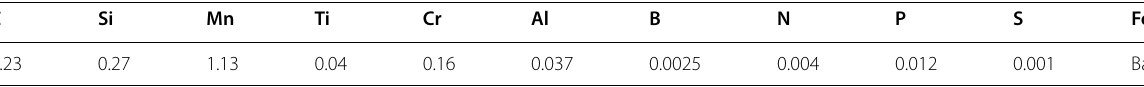
Table 1 Chemical composition of test steel (wt.%)